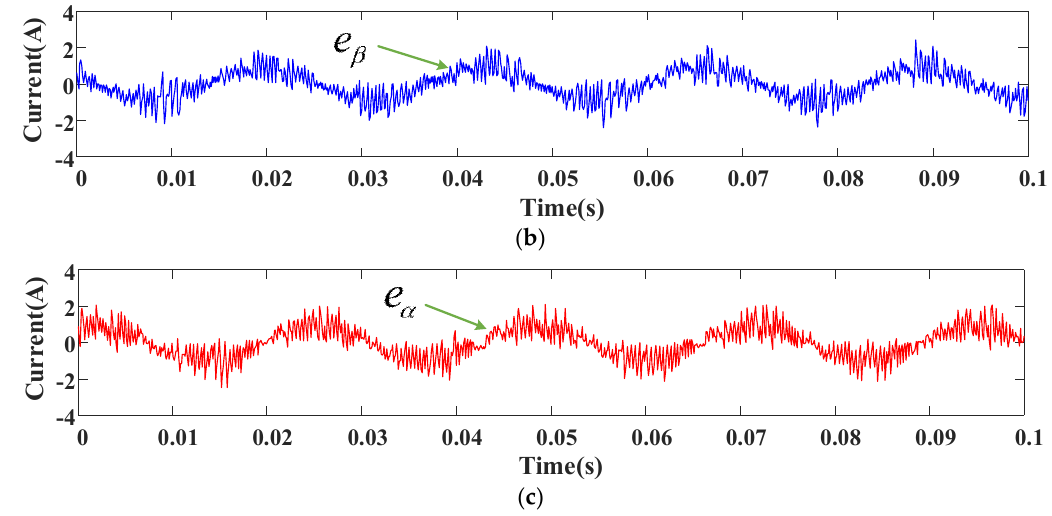
Figure 20. Experimental results of SVV-MPCC under speed 1300 rpm and load 1 Nm (case 4): ( a ) current responses; ( b ) α -axis current error; ( c ) β -axis current error.